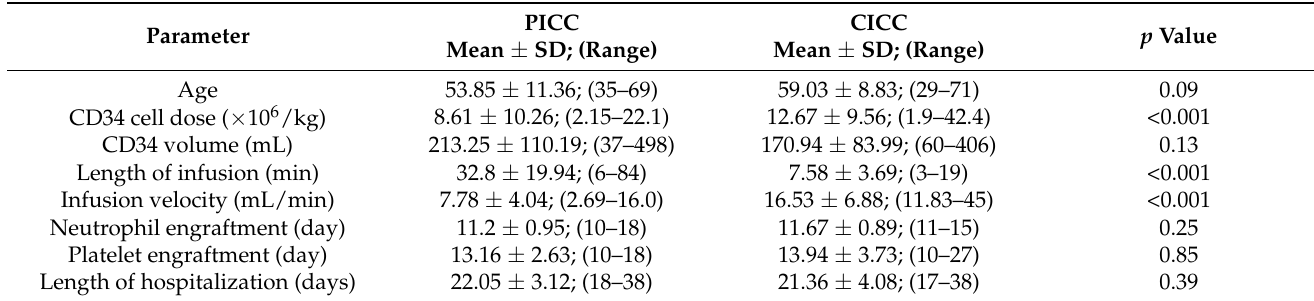
Table 2. Comparison between the PICC and CICC